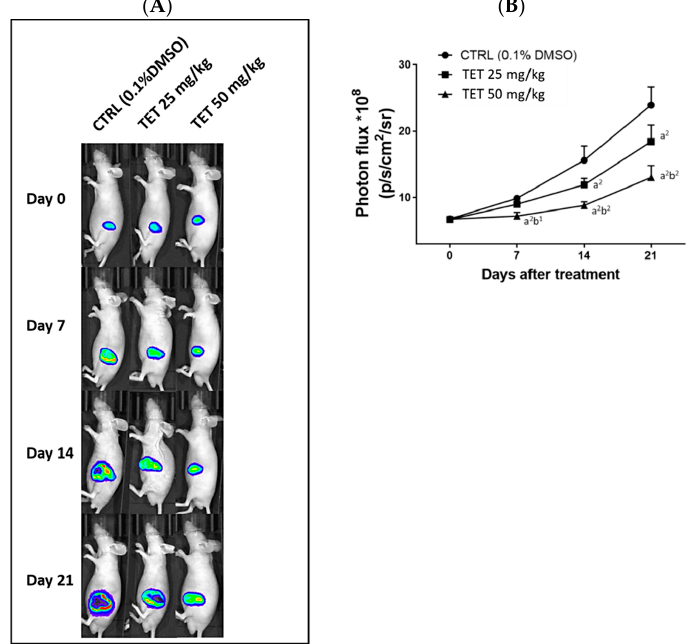
Figure 4. TET-suppressed Luc2 signals from living tumor cells. Animals were injected with GBM 8401/ luc2 cells and Luc2 signals of the tumors from each group were further measured. The representative BLI results from each group at different time points ( A ). Quantification results of Luc2 signal intensity of tumors ( B ). (a 2 < 0.01 vs. control; b 1 p < 0.05 and b 2 < 0.01 vs. TET 25 mg/kg). Table 3. The accurate p -value in Figure 4B is displayed. Here we summarized the p -value between control and two treatment groups of Luc2 signal intensity Compares Group TET 25 mg/kg TET 50 mg/kg Day 7